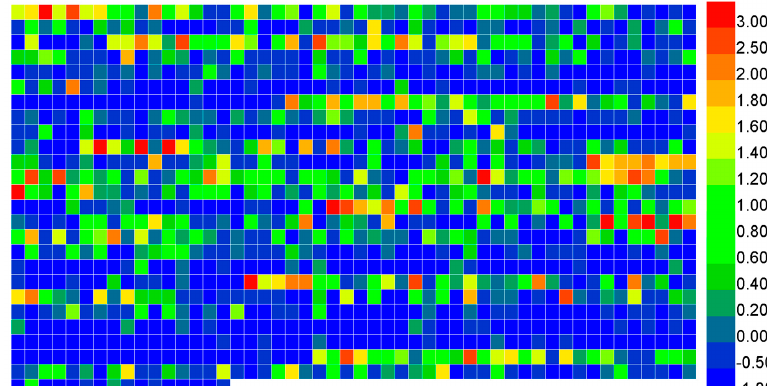
Figure 3. A heat map for 1266 features based on different Z-scores.